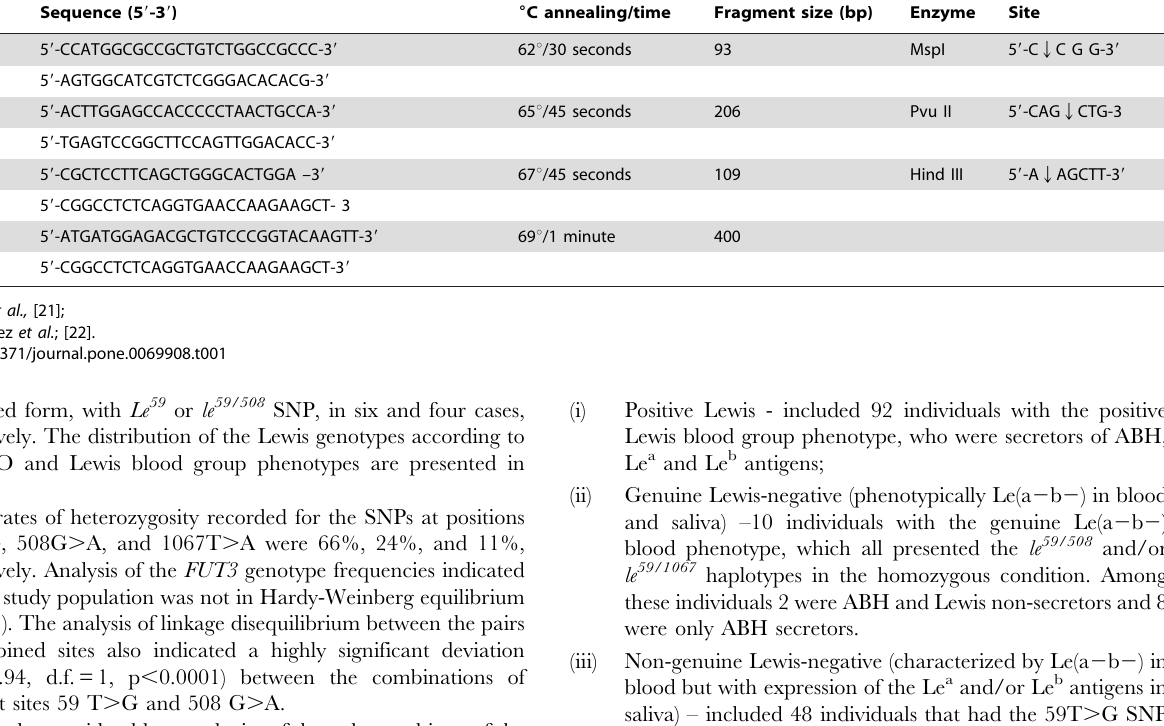
Table 1. Amplification conditions for the FUT3 gene and its restriction sites for the different endonucleases analyzed in the present study.